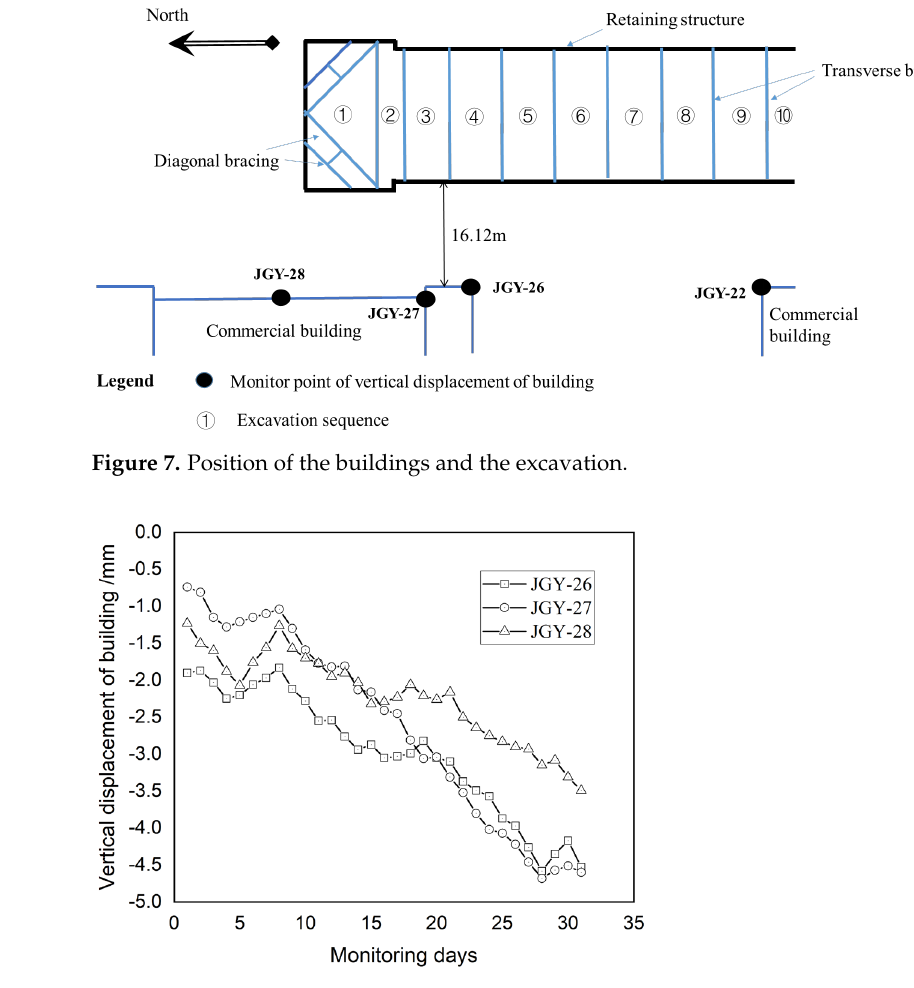
Figure 7. Position of the buildings and the excavation.